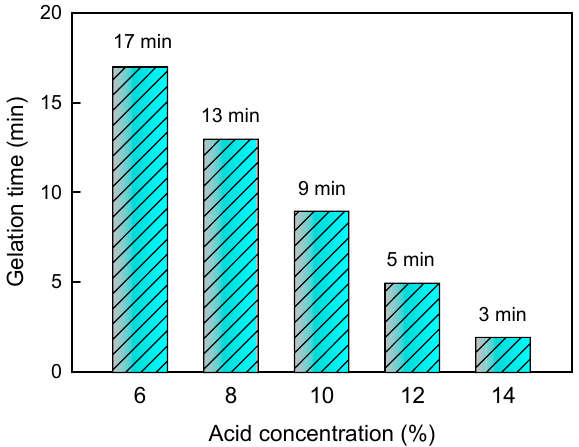
Figure 3. Effect of hydrochloric acid concentration on the gelation time of the composite membrane. Figure 3. E ff ect of hydrochloric acid concentration on the gelation time of the composite